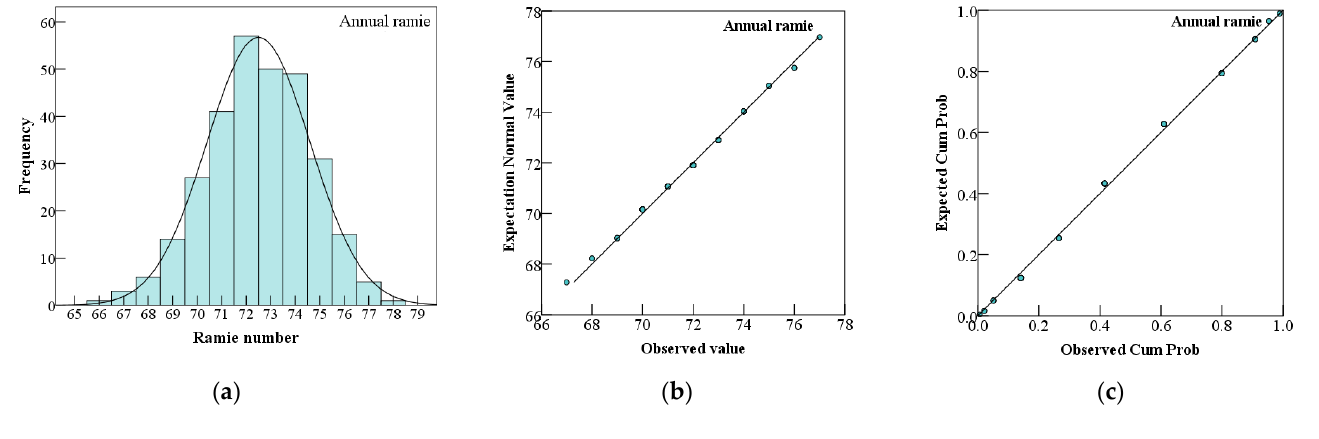
Figure 6. Graphic qualitative judgment of annual ramie. ( a ) Histogram; ( b ) Normal Q-Q Plot; ( c ) Normal P-P Plot.